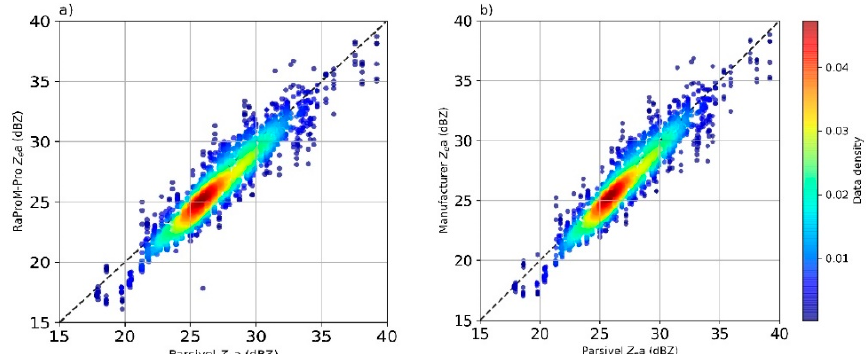
Figure 4. Scatter plots of equivalent radar reflectivity of the lowest valid height bin (150 to 200 m above radar level) of ( a ) RaProM- Pro and ( b ) the manufacturer processing vs. the Parsivel disdrometer located at the radar level. Coefficients of determination are equal to 0.878 (RaProM- Pro ) and 0.879 (manufacturer) for 1195 samples. Data were recorded on 21 April 2020 from 10 h to 14 h UTC.